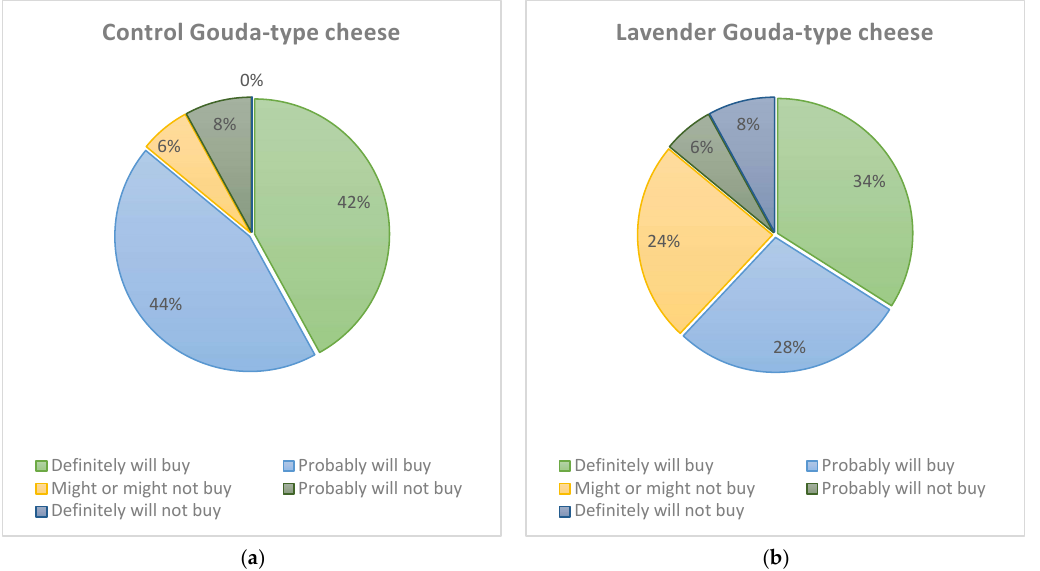
Figure 5. Response rates (%) for purchase intention of ( a ) control Gouda-type cheese; ( b ) lavender Gouda-type